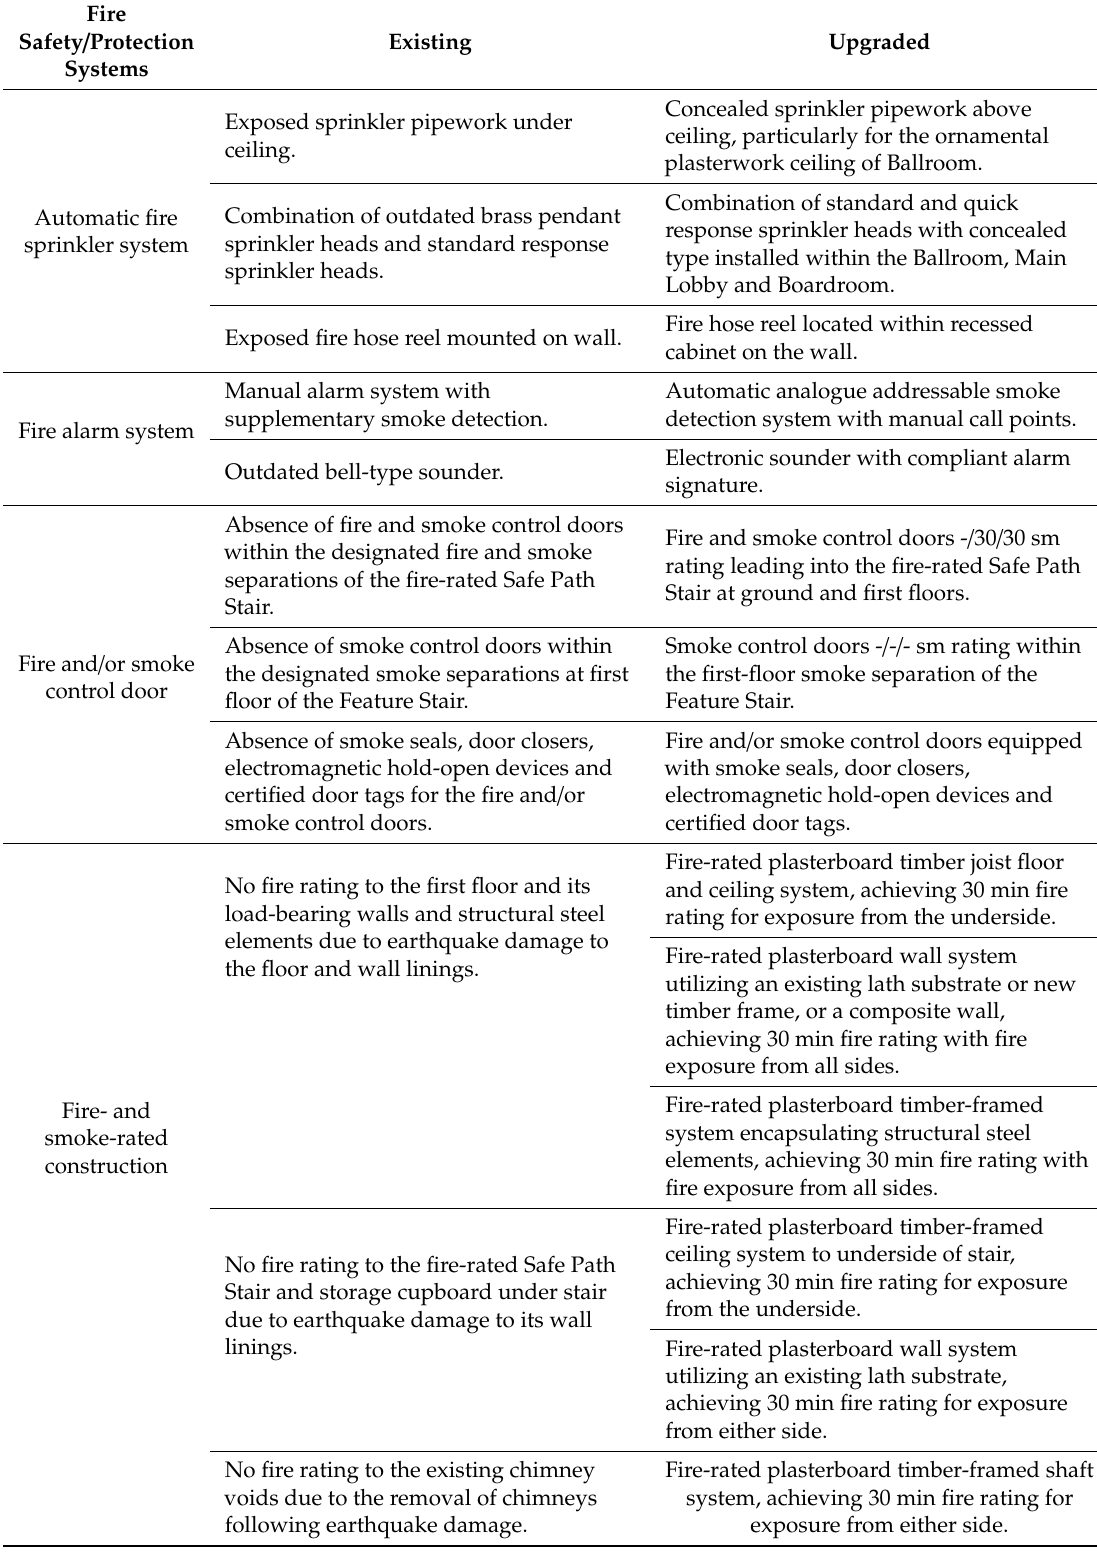
Table 7. Existing and upgraded conditions of the fire safety and fire protection systems of McDougall